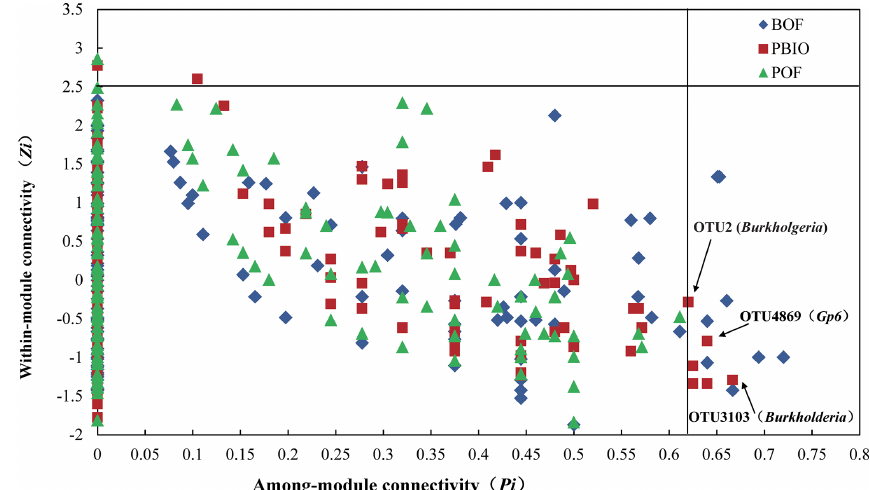
Figure 6. Zi–Pi plot showing the distribution of OTUs based on their topological roles. Each symbol represents an OTU in different treatment. BOF – banana continuously cropped with OF application; POF – banana–pineapple rotation with OF application in the banana season; PBIO – banana–pineapple rotation with BIO application in the banana season; the threshold values of Zi and Pi for categorizing OTUs were 2.5 and 0.62, respectively, as proposed by Guimera and Amaral (2005) and simplified by Olesen et al. (2007).